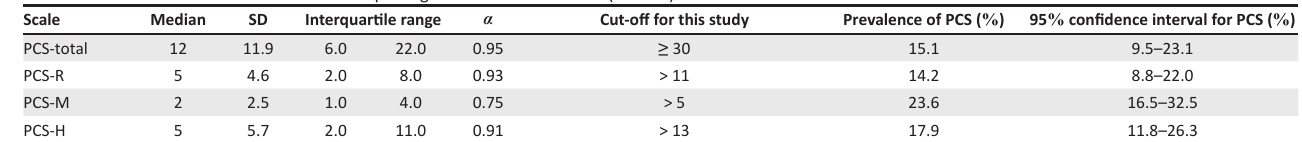
TABLE 3: Scores obtained for the Pain Catastrophising Scale and its subscales ( n = 106). Scale